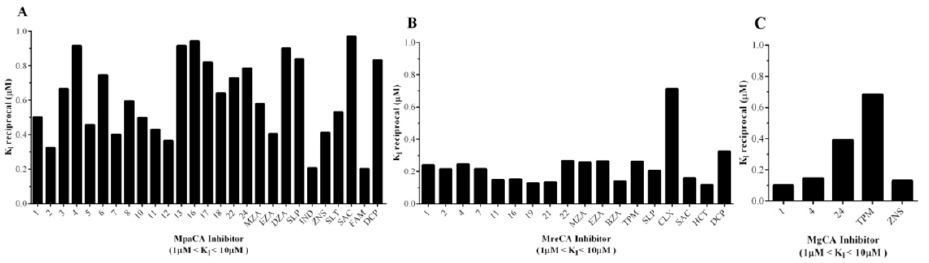
Figure 6. Graphical representation of the sulfonamide compounds exhibiting inhibitor activity with K I values in the range between 1 and 10 μ M with respect to MpaCA (Panel A ), MreCA (Panel B ), and MgCA (Panel C ). The K I values are reported as the reciprocal to have the highest column to the best enzyme inhibitor.